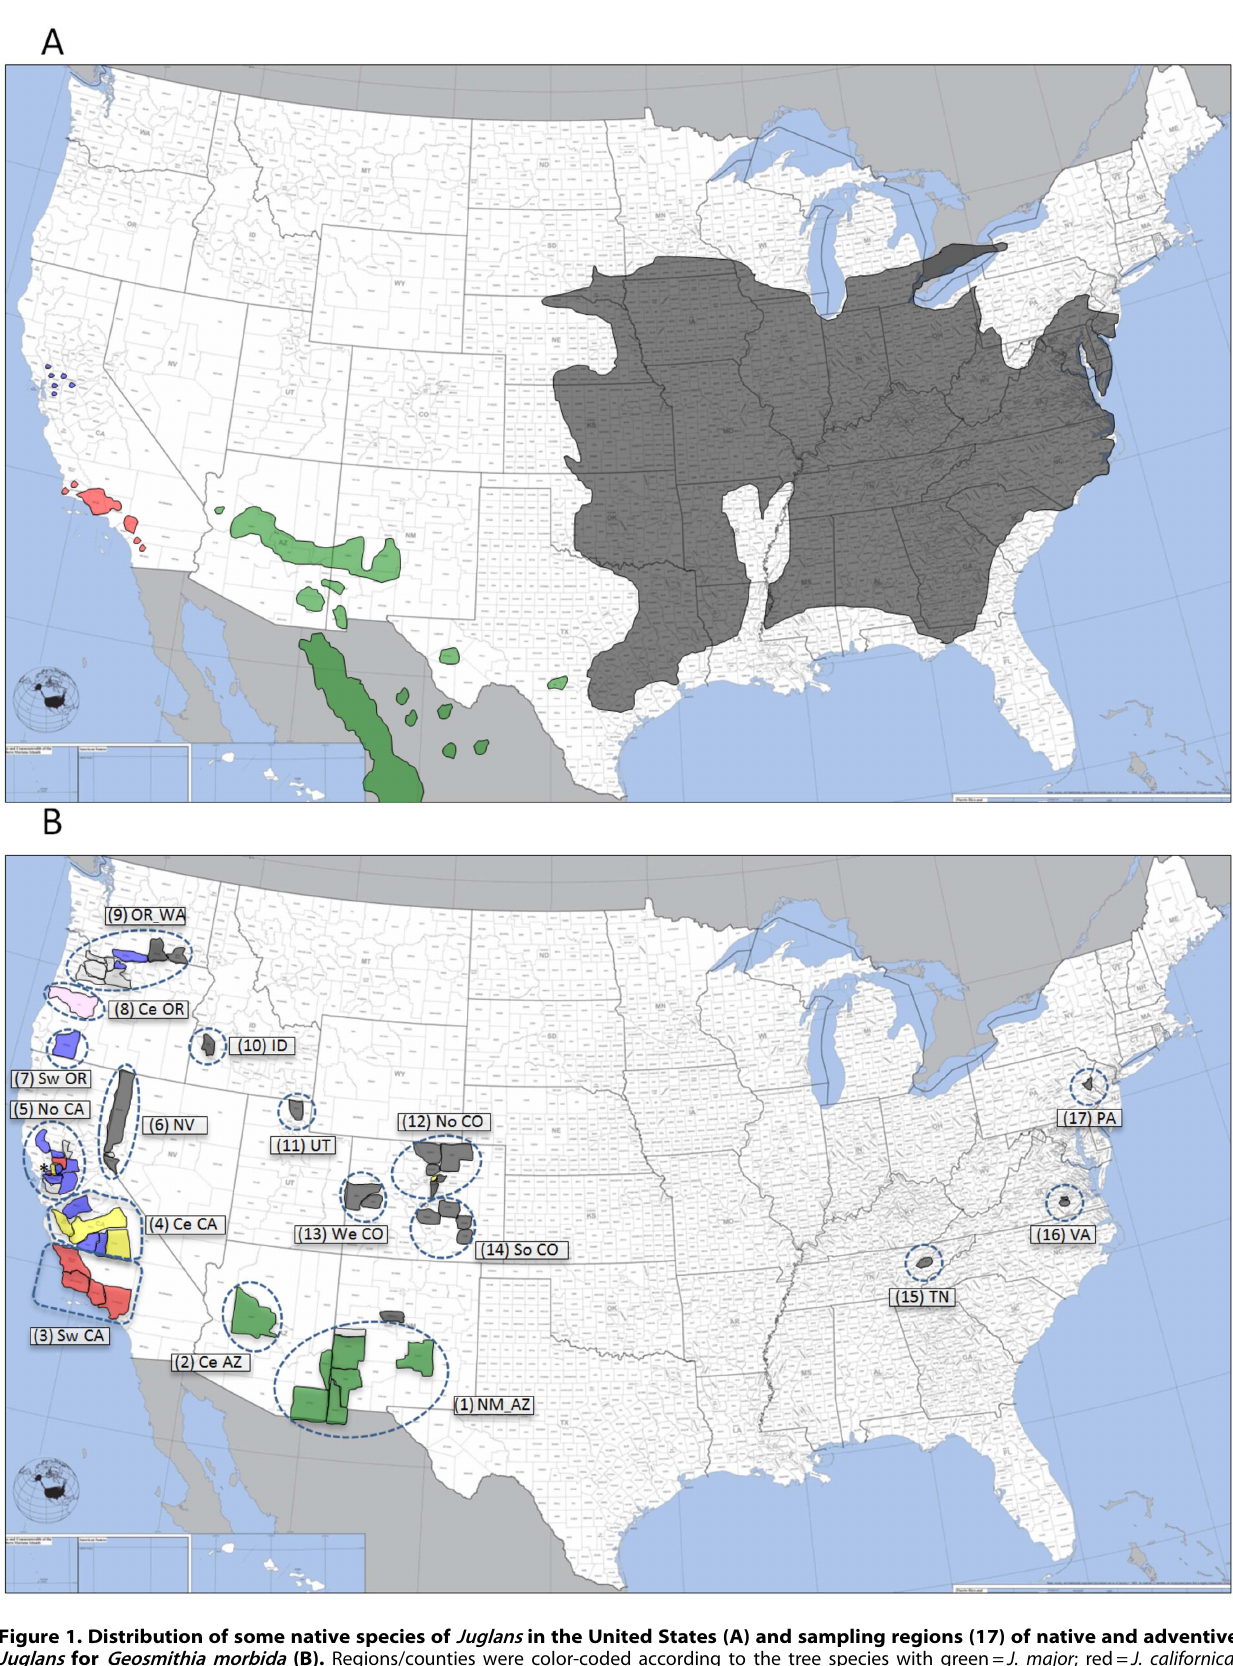
Figure 1. Distribution of some native species of Juglans in the United States (A) and sampling regions (17) of native and adventive Juglans for Geosmithiamorbida (B). Regions/counties were color-coded according to the tree species with green= J. major ; red= J. californica ; yellow= J. regia ; blue= J. hindsii ; black= J. nigra ; pink= J. cinerea ; light gray=unidentified Juglans spp. or hybrids. (Figure adapted from U.S. Census Bureau and U.S. Geological Survey at https://www.census.gov/). doi:10.1371/journal.pone.0112847.g001 PLOS ONE | www.plosone.org